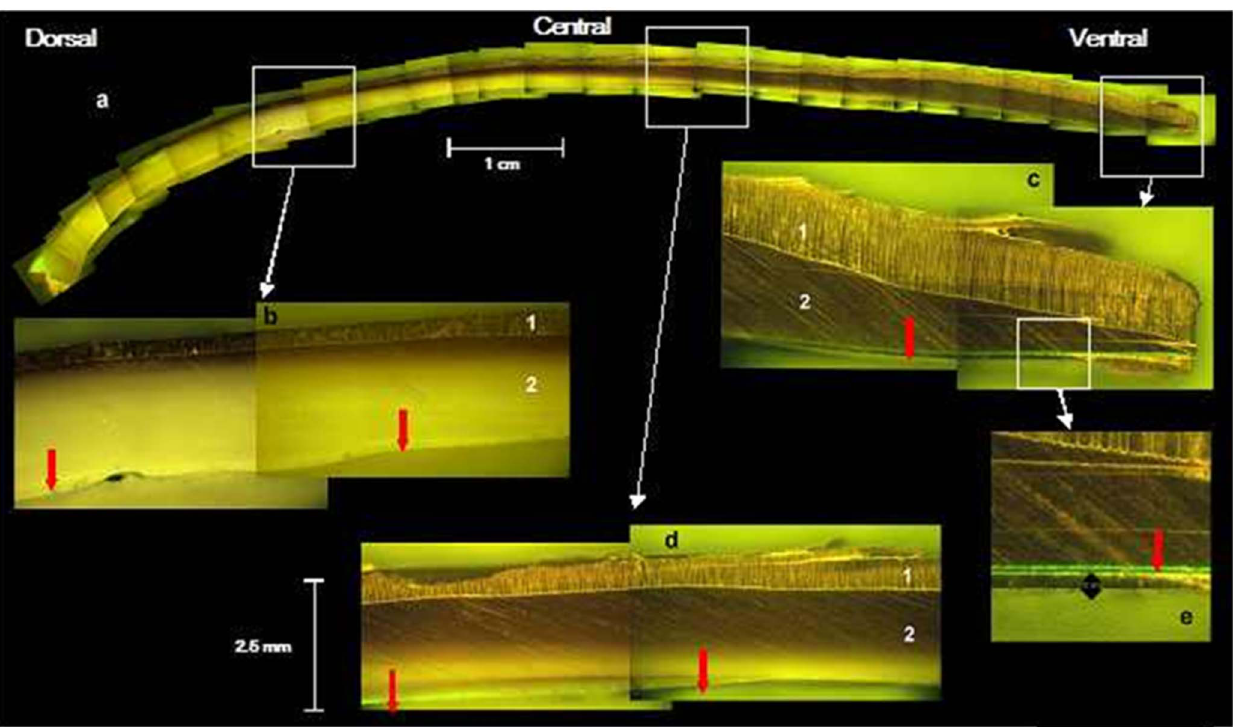
Figure 1. Section of a valve of a P.margaritifera shell. (a) dorso-ventral side showing the transition areas between nacreous and prismatic layers. (b) dorsal part; (c) ventral part; (d) central part; (e) detail of ventral part. (1) prismatic calcite; (2) aragonite tablets. The red arrows indicate the calcein mark.